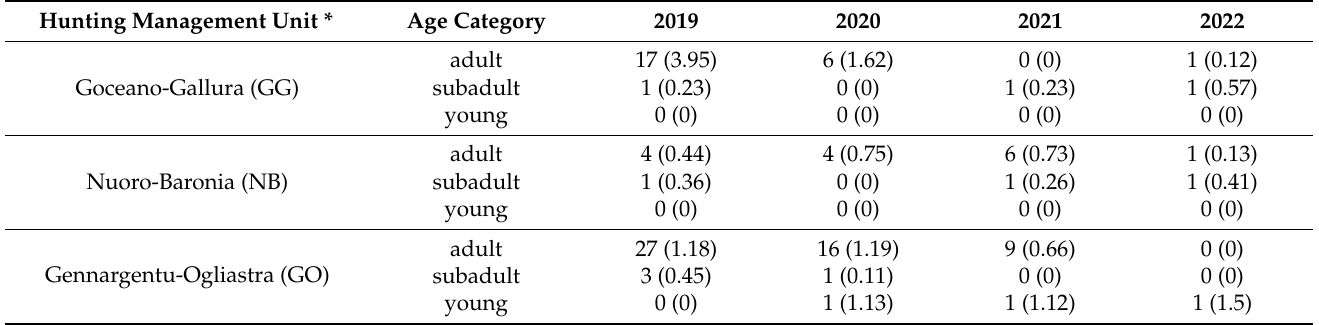
Table 2. ASF seroprevalence in wild boar in the infected area, detected by active surveillance divided by animal age categories and wild boar hunting management units (HMUs), since the 9 April 2019.